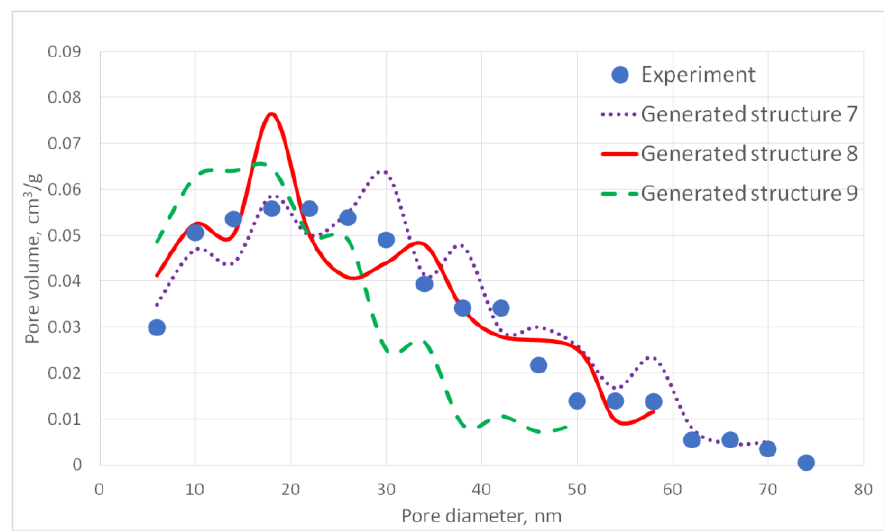
Figure 3. Pore size distribution curves for generated PA structures 4–6.